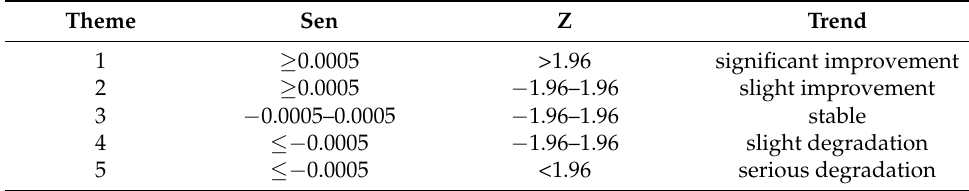
Table 2. The categories for vegetation cover trend. Theme Sen Z